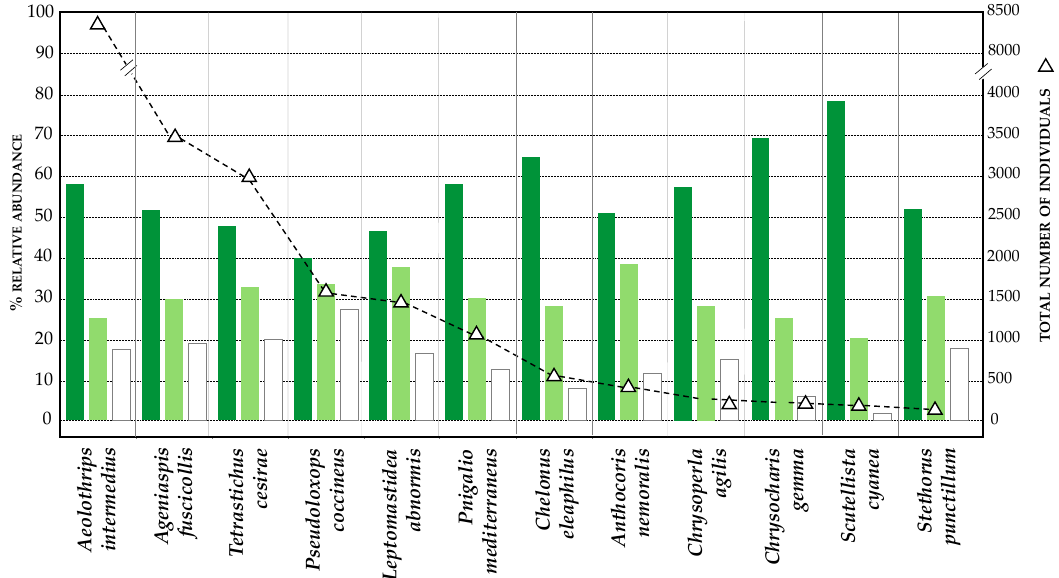
Figure 3. Total number of individuals captured for the different species of natural enemies (right axis) and capture percentages for each of the three agricultural management (left axis): VC-MIX olive grove (white), VC olive grove (light green), and conventional management (dark green).